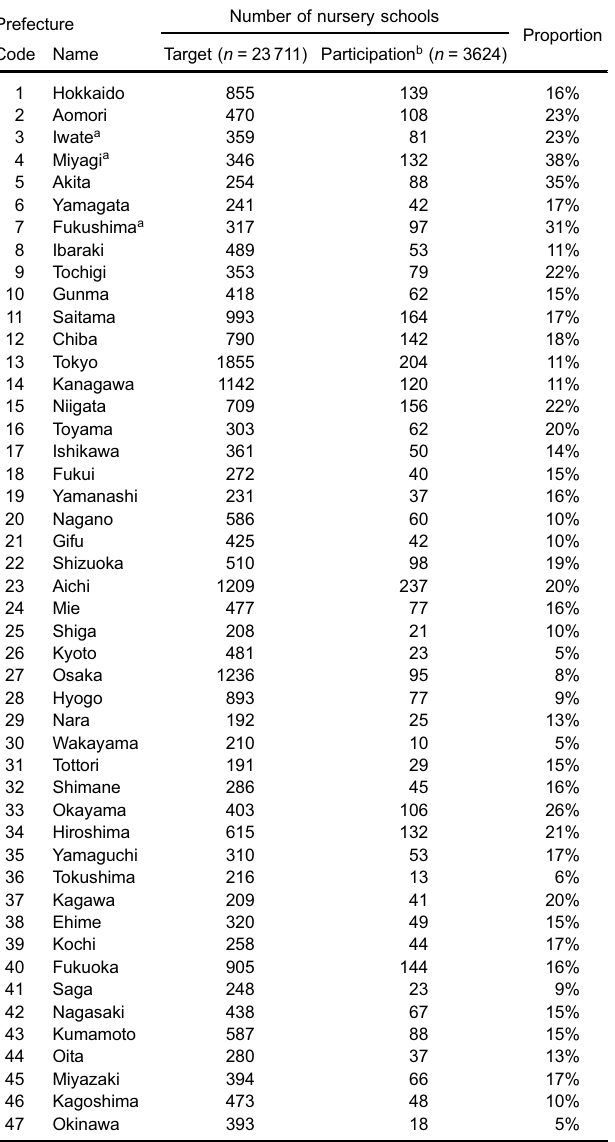
Table 1. Proportion of nursery schools that participated in the survey Prefecture Number of nursery schools Code Name